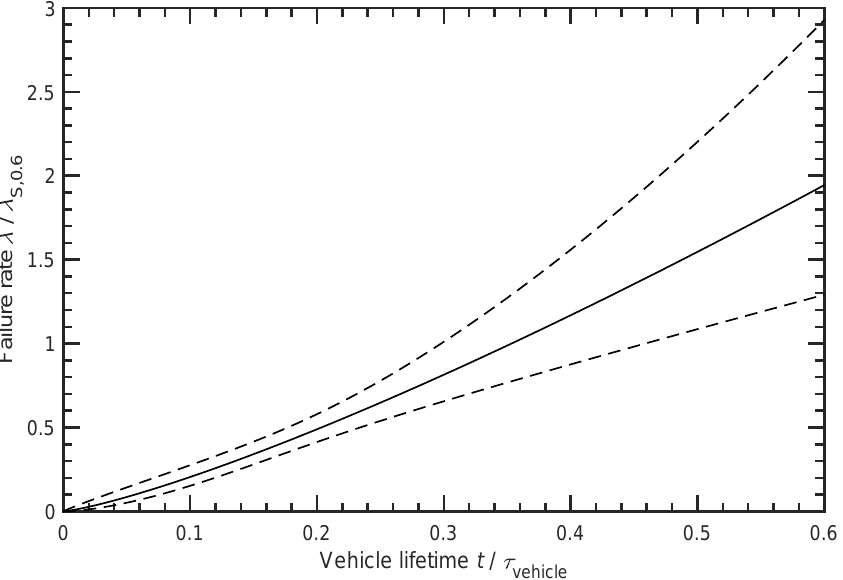
Figure 6. The normalised failure rate λ WOA ( t ) of the failure mode Worn out and Abused with a shape parameter b = 2.255 and a normalised scale parameter T = 0.826 is shown. In addition, the upper and lower confidence limits for a confidence level of 95% are